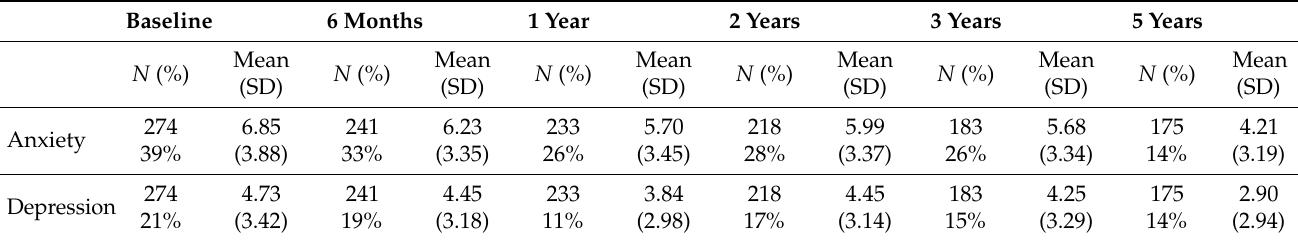
Table 3. Sample size (N) and percentages of patients with a mean score above the cut-off of 7 for anxiety and depression during all time points (baseline, six-month, one-, two-, three- and five-year follow-up). The cut-off of 7 defines the presence of clinically significant symptoms of anxiety and depression. Means and standard deviations (SD) of the sample for each time point are also